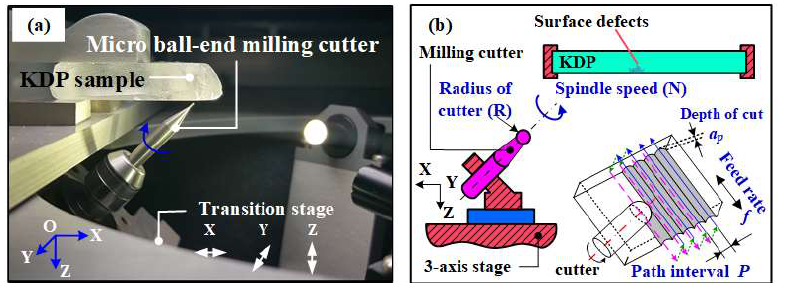
Figure 3. ( a ) Image of micro-milling repair system for KDP [46] and ( b ) the schematic of milling processes with parallel trajectory [21].